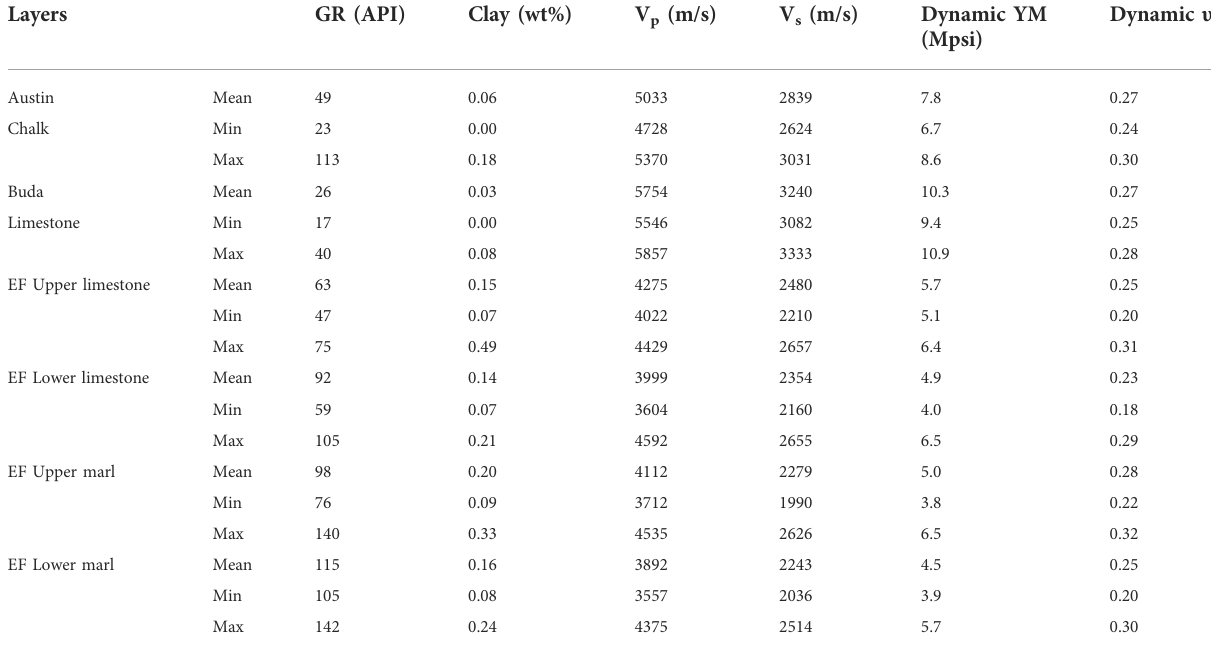
TABLE 5 Summary of elastic parameters in different layers of the Eagle Ford and adjacent formation in La Salle County.